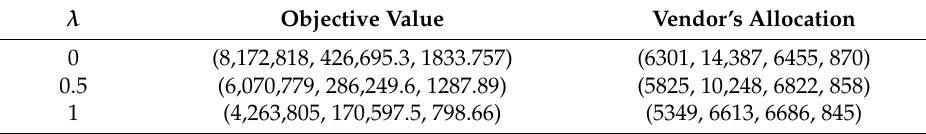
Table 12. Compromise objective value and allocation for case 2 without fixed demand.